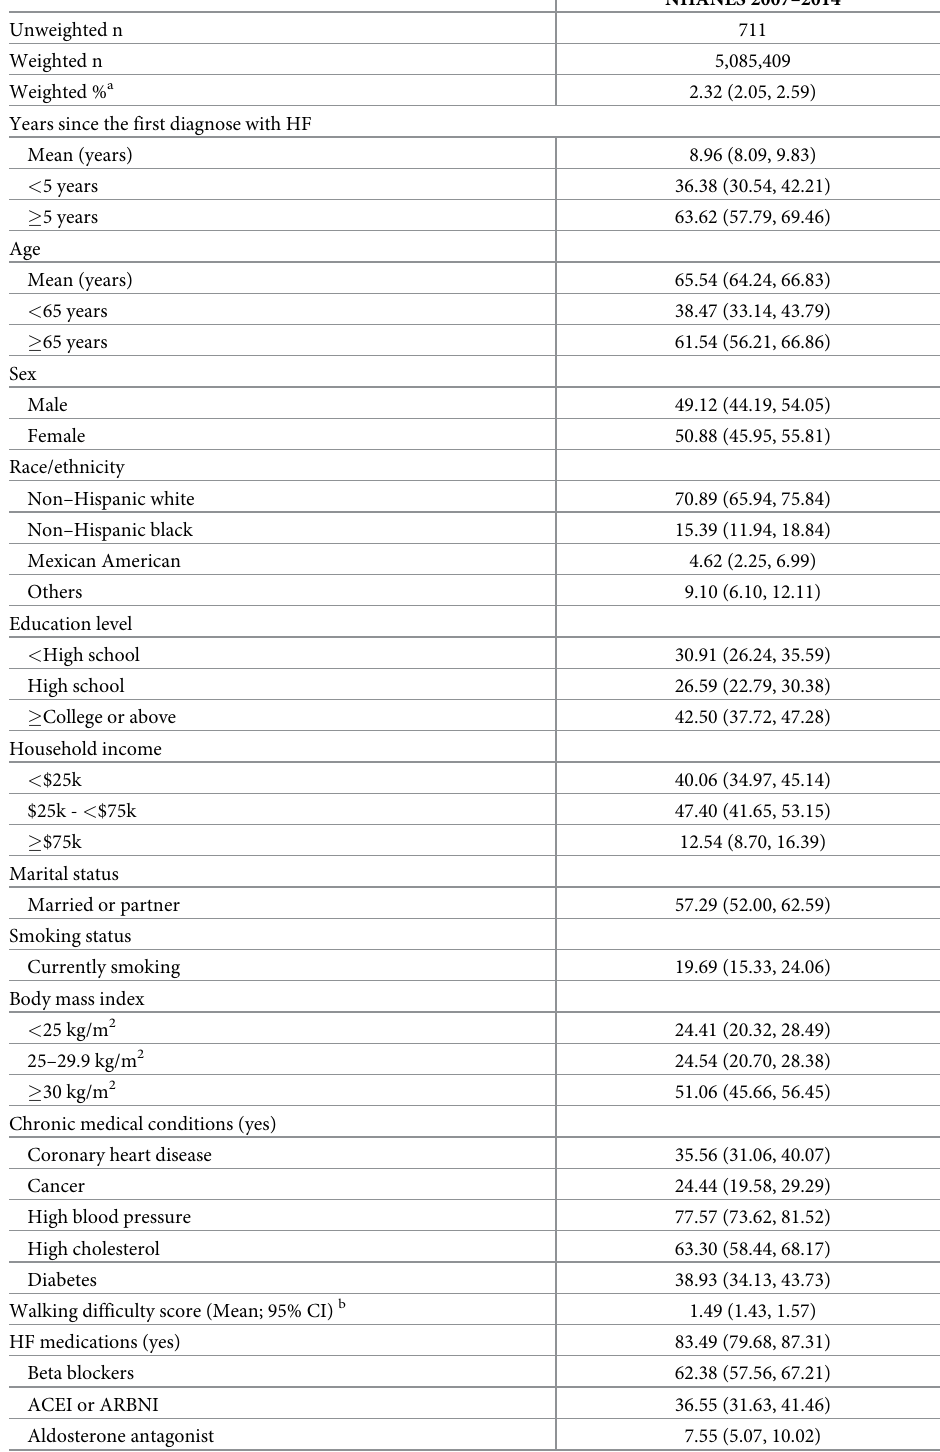
Table 1. Descriptive characteristics of the US adults with a history of congestive heart failure (NHANES 2007–